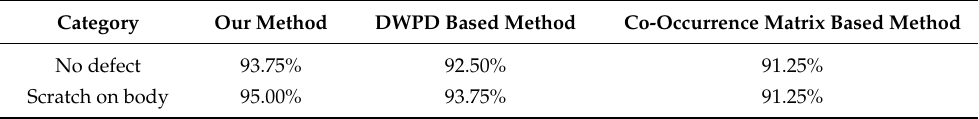
Table 3. Classification accuracy for body defect